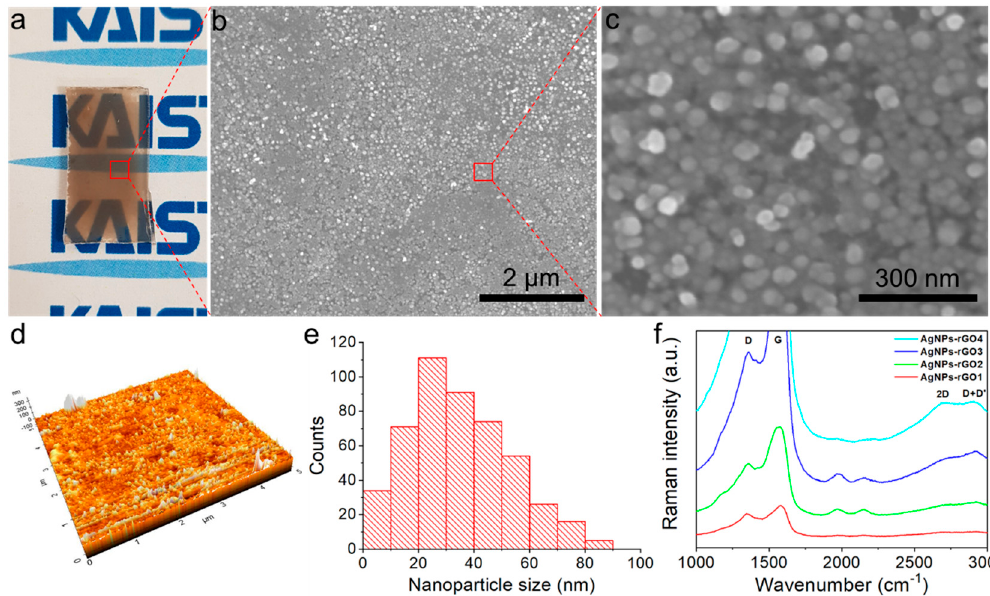
Figure 2. Characterization of the AgNPs-rGO composites. ( a ) Photograph of the AgNPs-rGO1 SERS substrate; ( b , c ) The SEM images clearly showed the narrow nanogap-rich structures; ( d ) Atomic force microscopy (AFM) images of the AgNPs-rGO1 substrate; ( e ) Particle size distribution of the AgNPs-rGO1 substrate exhibiting the median size of AgNPs was 33 nm; ( f ) Raman spectra of various AgNPs-rGO composites. The D and G Raman bands of the AgNPs-rGO3 and AgNPs-rGO4 substrates were not figured as the signals were saturated.